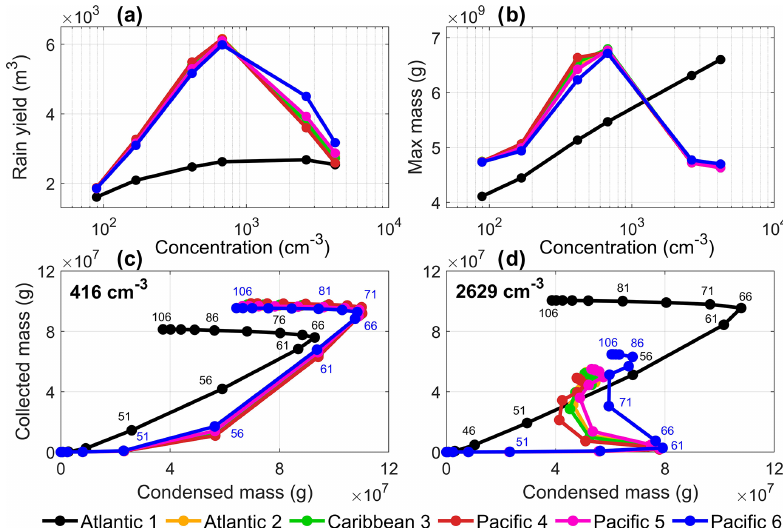
Figure 2. (a) Surface rain yield and (b) cloud’s maximum mass as a function of N tot used in the simulation, integrated over 150min of simulations. Each curve represents six simulations, done with a specific shape of the MSD normalized to different aerosol concentrations. The lower panels (c, d) show the time evolution of accumulated condensed mass versus accumulated collected mass. The simulated time is noted along the black and blue curves for the Atlantic-1 and Pacific-6 MSDs, respectively. The panels represent an aerosol concentration of 416 and 2629cm − 3 (panels c and d ,